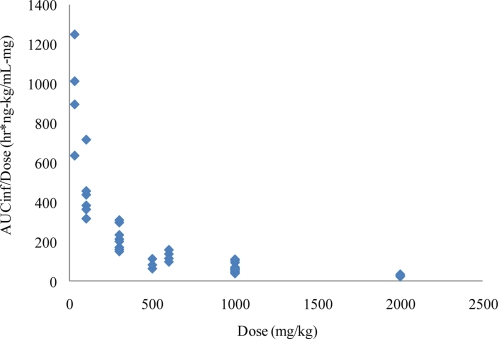
Dose normalized exposure of ST-246 in BALB/c mice from Day 1 of multiple studies. Dose normalized area-under-the curve values are plotted versus dose for mouse toxicology studies. The results suggest that absorption limits increased exposure as the dose is increased. AUCinf = Area under concentration time curve for plasma drug levels after oral dosing from time 0 extrapolated to infinite time.